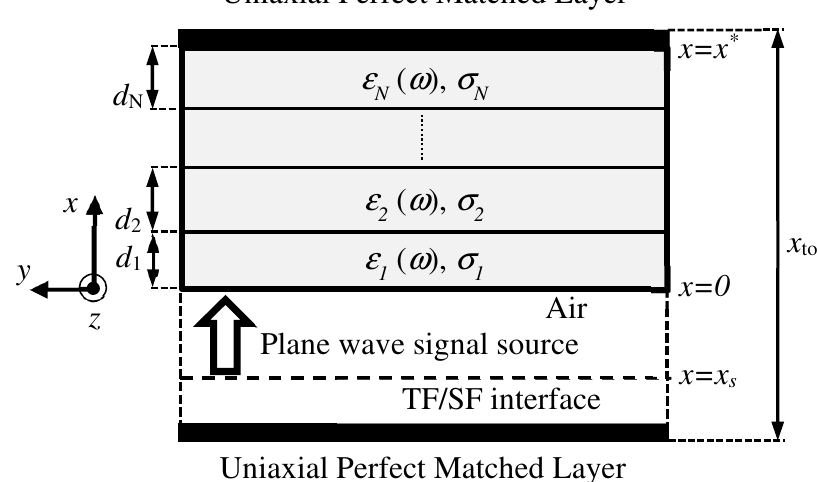
Figure 1. Sketch of the layered dielectric system employed in the simulations. The first test case is relevant to a single-layer structure with thickness d 1 = 10 mm, electric conductivity σ 1 = 0.035 S m − 1 , and time-harmonic relative permittivity function